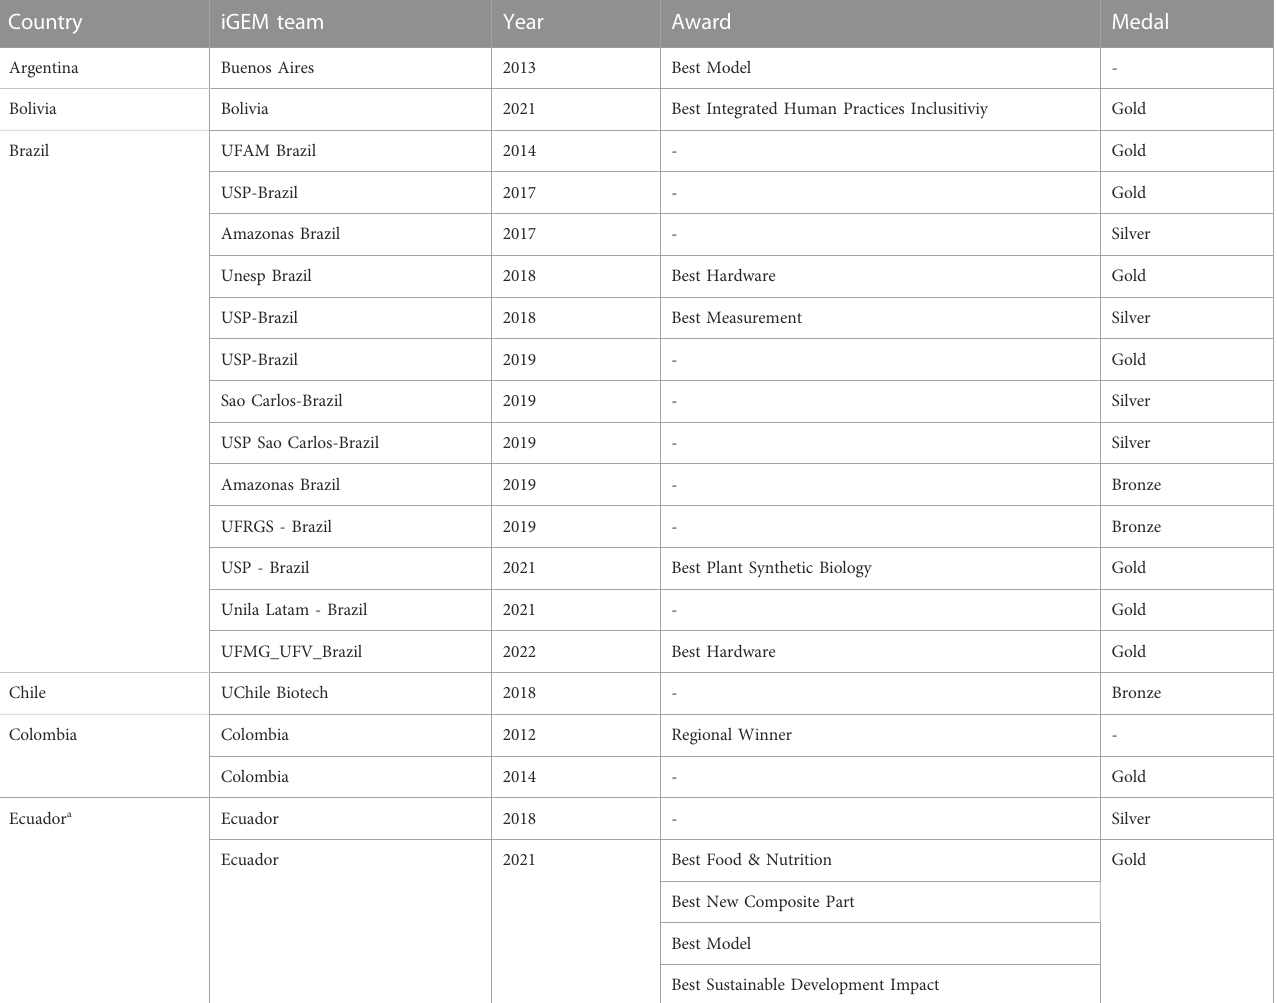
TABLE 1 Awards and medals given to South American iGEM teams at Jamborees.